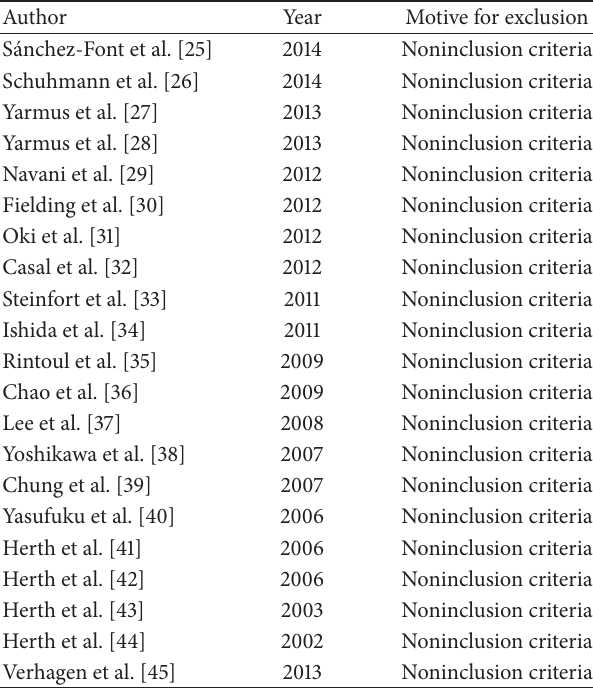
Table 5: Excluded studies and motive for